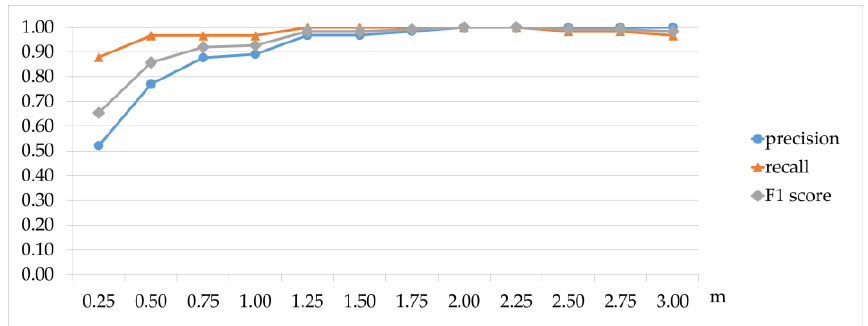
Figure 15. Precision, recall and F 1 score values according to different m parameter values.